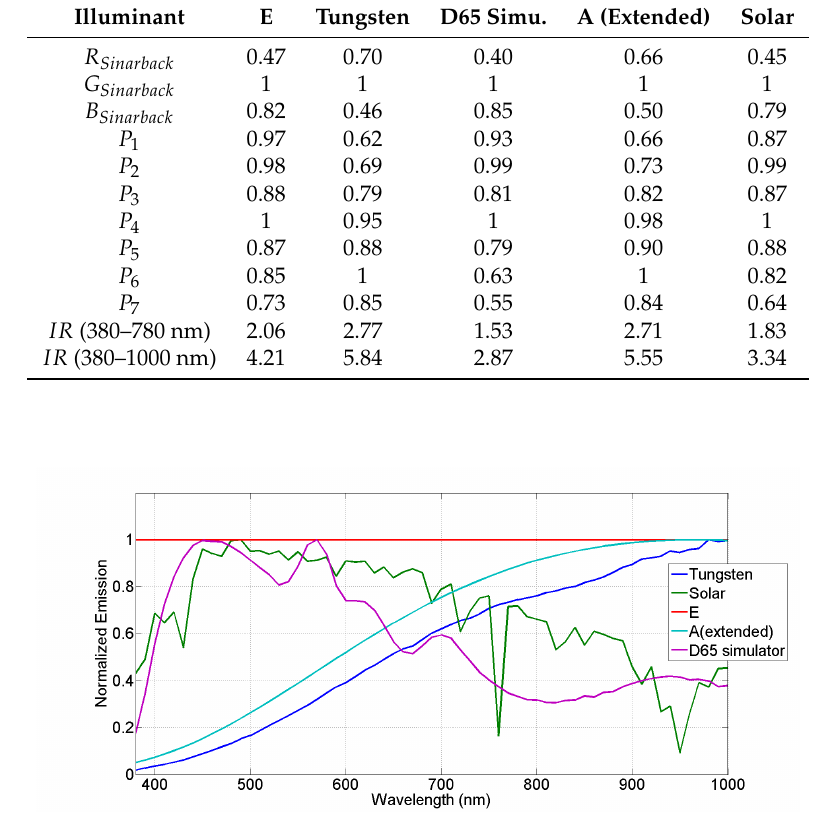
Figure 8. Multiple illuminants used for the energy balance study given in Table 3. The tested wavelength range is 380–1000 nm. The D65 simulator spectral emission is used for the acquisition of the image database. Illuminant data are provided as Supplementary Materials in file Excel